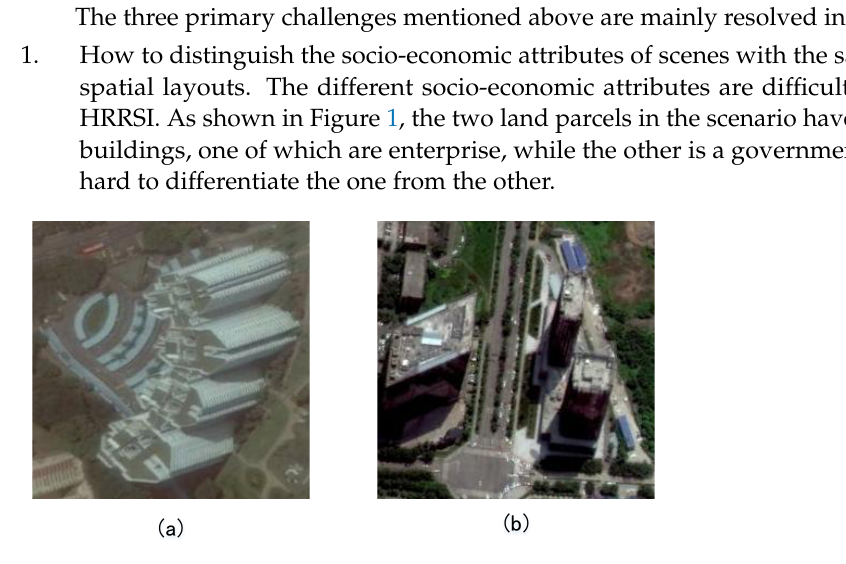
Figure 1. In Figure ( a ), from left to right, the first building to the third building are enterprises, and the fourth building is a government agency. In Figure ( b ), from left to right, the first and third buildings are enterprises, and the second building (in the middle) is the government